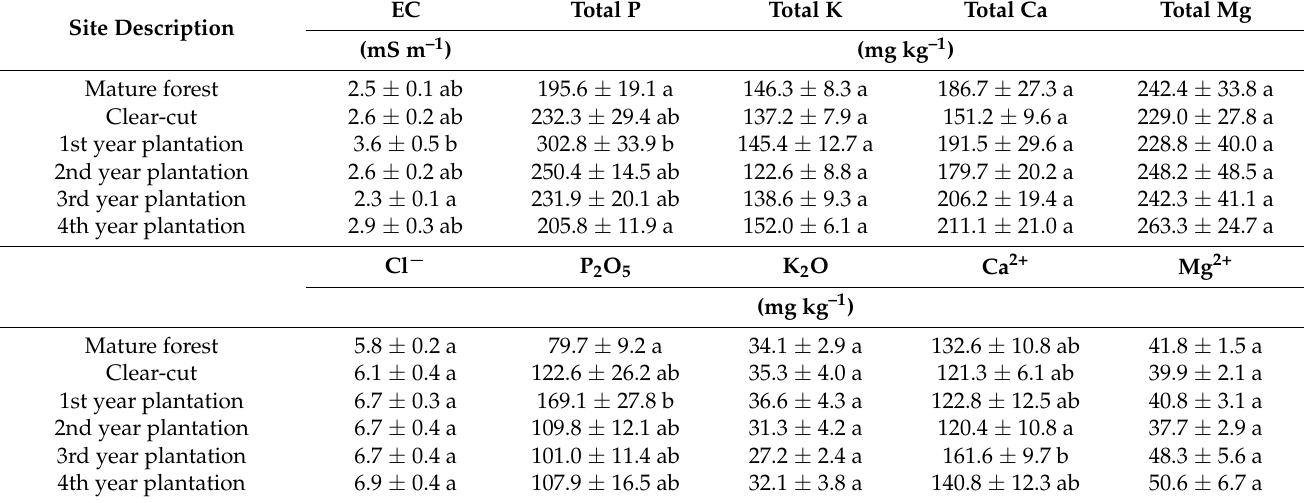
Table 2. Mean EC (mS m –1 ), mean concentrations of total phosphorus (P), potassium (K), calcium (Ca), magnesium (Mg), chlorides (Cl – ) (mg kg –1 ), and P 2 O 5 , K 2 O, Ca 2+ , and Mg 2+ in the 0–20 cm topsoil layer in the mature forest, clear-cut, and reforested 1st–4th year Pinus sylvestris L. plantations. The data from three study sites (A, L, and V) were combined. The values followed by different letters a and b within each column indicate statistically significant differences between the sampling sites at p < 0.05.